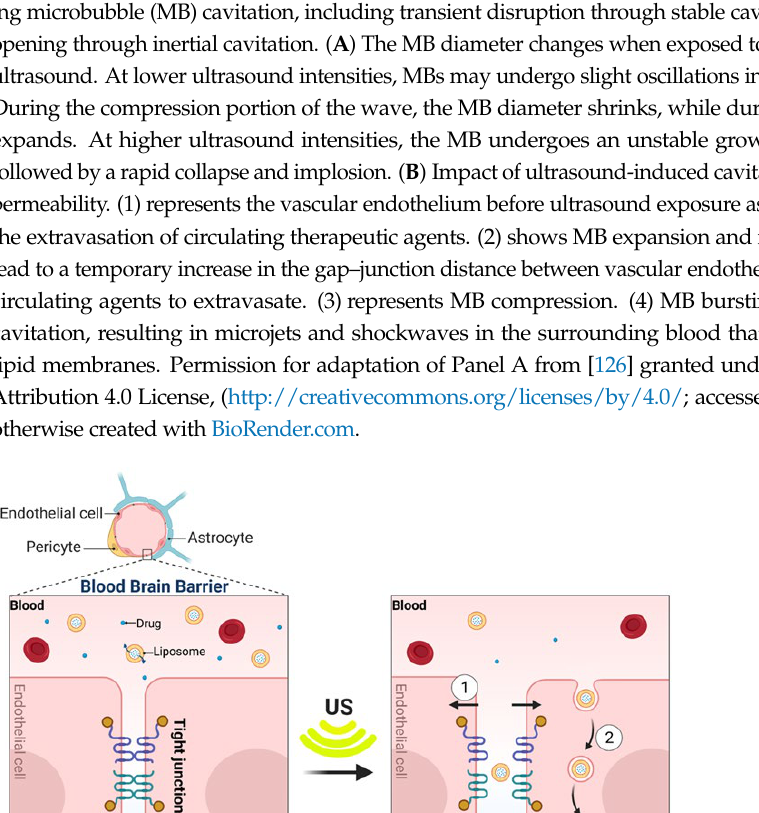
Figure 5. Mechanisms by which ultrasound affects the blood–brain barrier at the cellular level. ( 1 ) Interaction of MBs and ultrasound transiently disrupts the tight junction of the endothelial cells to facilitate paracellular transport. ( 2 ) Ultrasound-mediated mechanical forces increase the transcellular transport across endothelial cells by several membrane poration mechanisms to shuttle the drug out of the vessel lumen into the brain. Permission for adaptation from [127] granted under Creative Commons Attribution 4.0 International License, (http://creativecommons.org/licenses/by/4.0/; accessed on 15 August 2022), otherwise created with